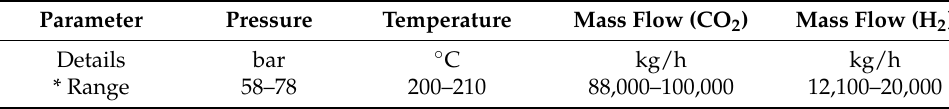
Table 6. ANN input’s